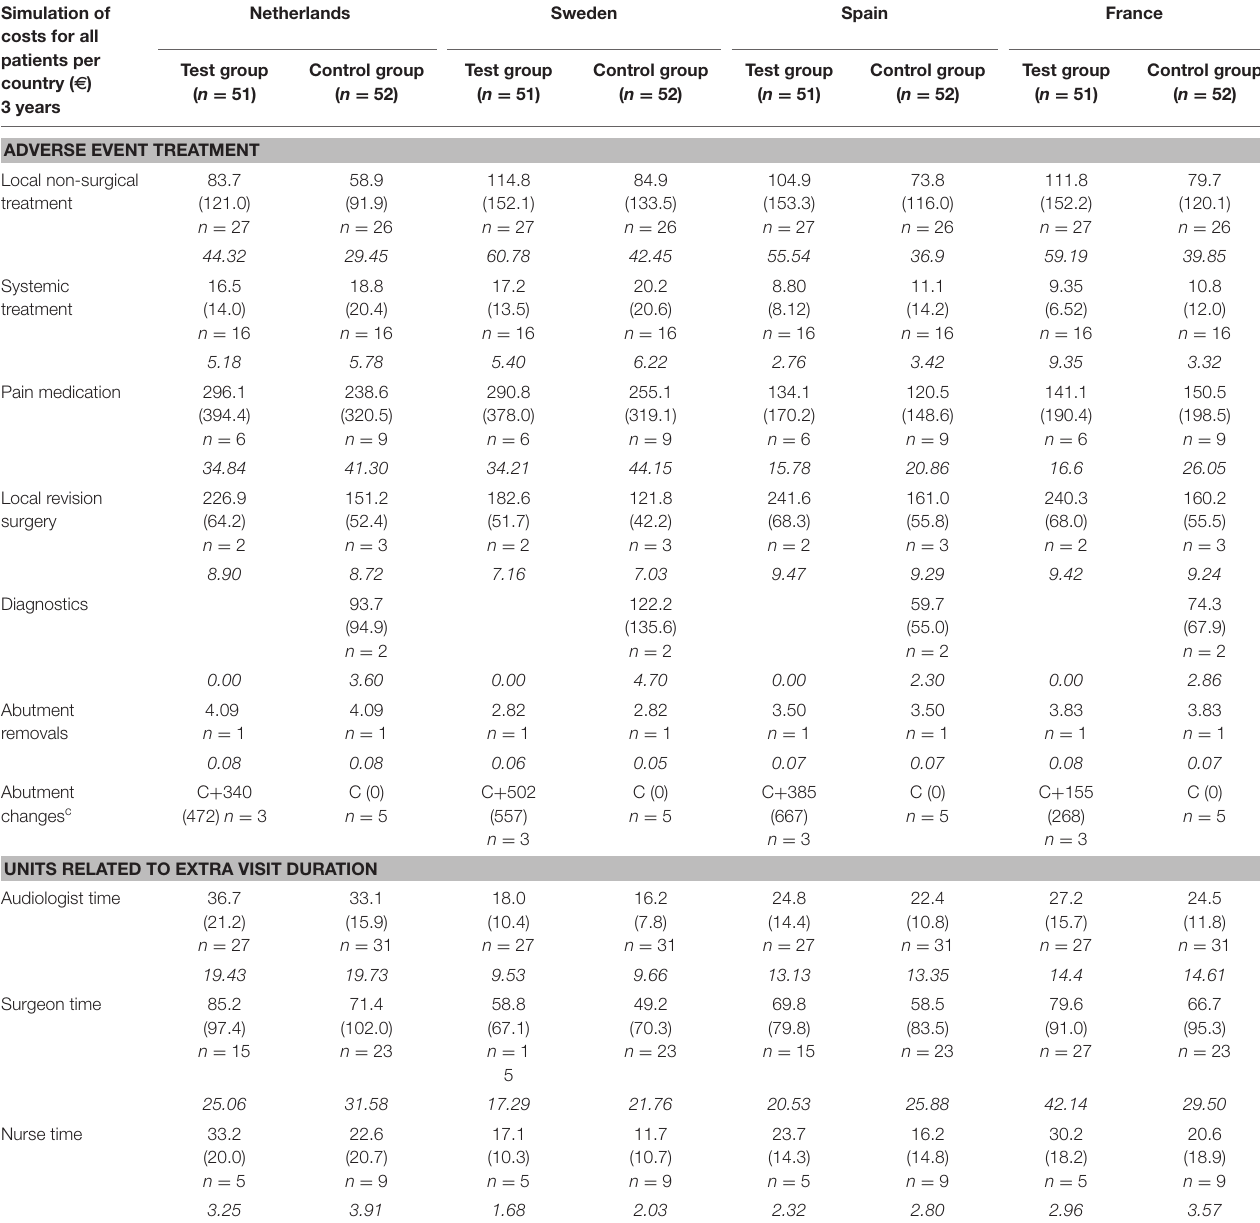
TABLE 5B | Scenario analyses: simulation of costs for all patients per country (3 years). Simulation of costs for all patients per country ( e